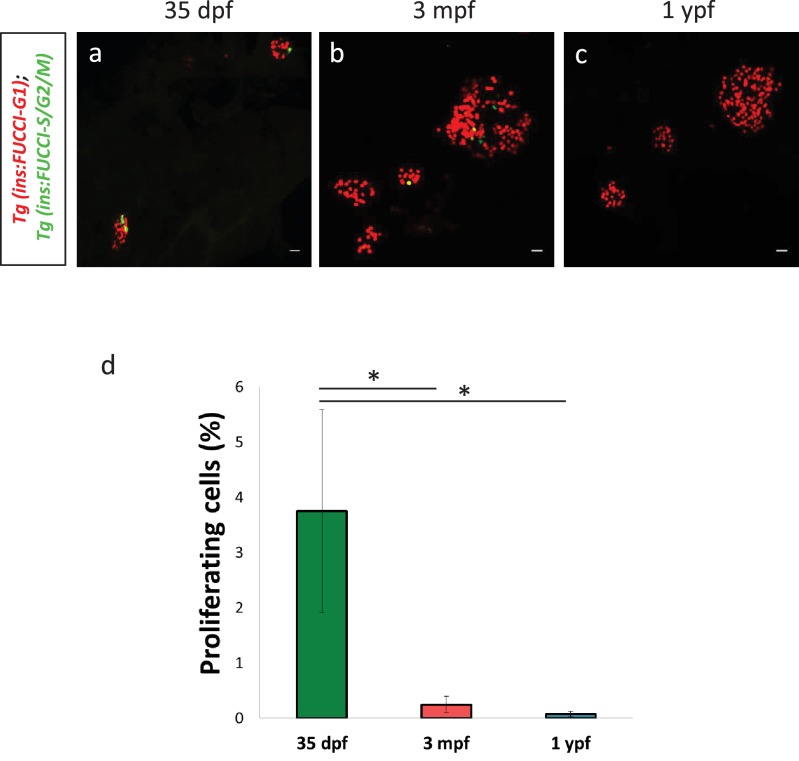
Beta-cell proliferation declines with age in secondary islets.(a,b) Confocal projection of whole-mount secondary islets from Tg(ins:Fucci-G1);Tg(ins:Fucci-S/G2/M) animals at 35 dpf, 3 mpf and 1 ypf. Scale bar 20 µm. (c) Quantification of percentage of Tg(ins:Fucci-S/G2/M)-positive and Tg(ins:Fucci-G1)-negative (green-only) beta-cells from 35 dpf (n = 8 fish, secondary islets = 16), 3 mpf (n = 8 fish, secondary islets = 70) and 1 ypf (n = 8 fish, secondary islets = 76) animals. Error bars show s.e.m. (one-way ANOVA, *p<0.05).